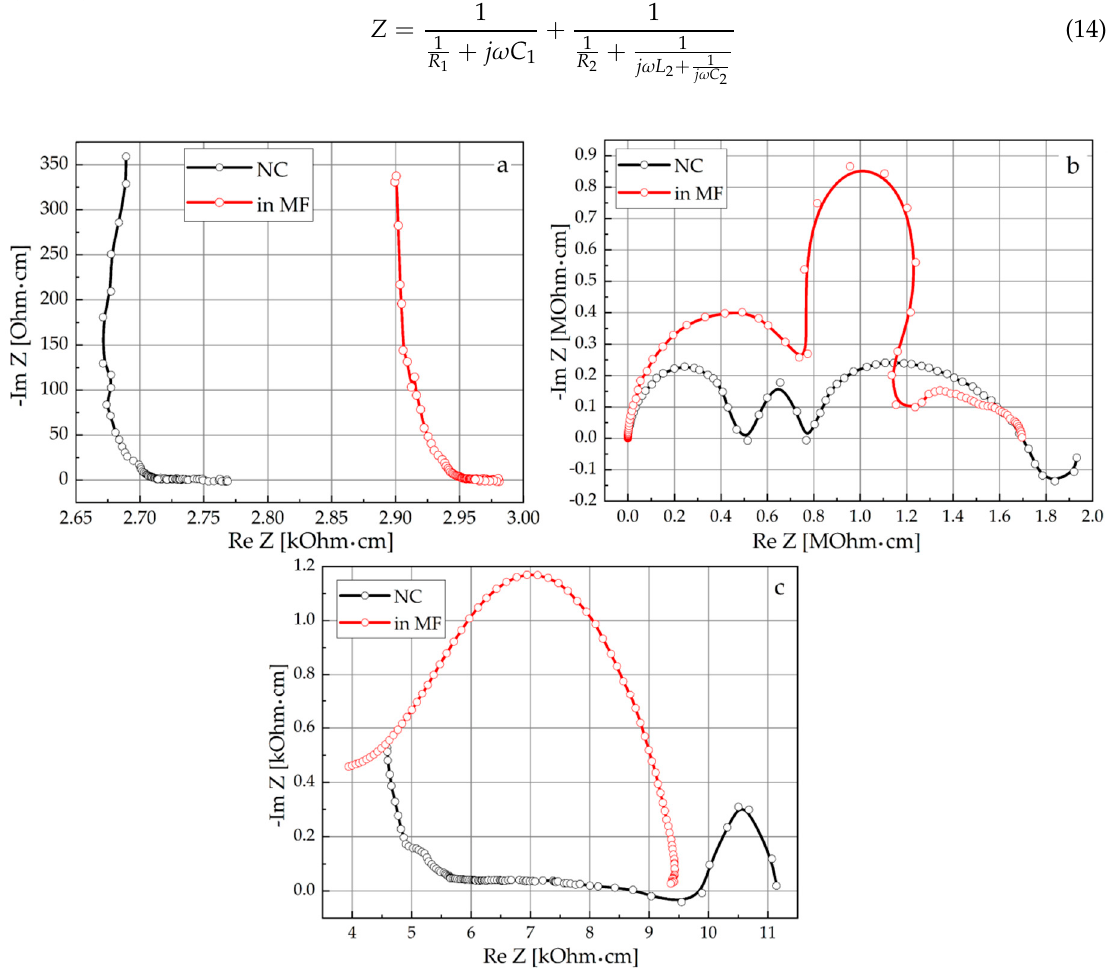
Figure 11. Nyquist plots for the synthesised hybrid structures GaSe ( SC(NH 2 ) 2 ) ( a ), GaSe ( SmCl 3 ) ( b ) and GaSe ( SC(NH 2 ) 2 ( SmCl 3 )) ( c ) measured under normal conditions (black) and under applied magnetic field (red).